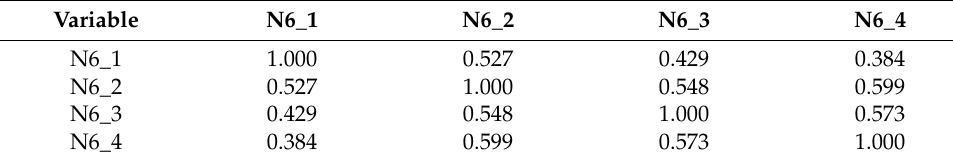
Table 7. Correlation matrix for willingness to employ PwD types 1 .